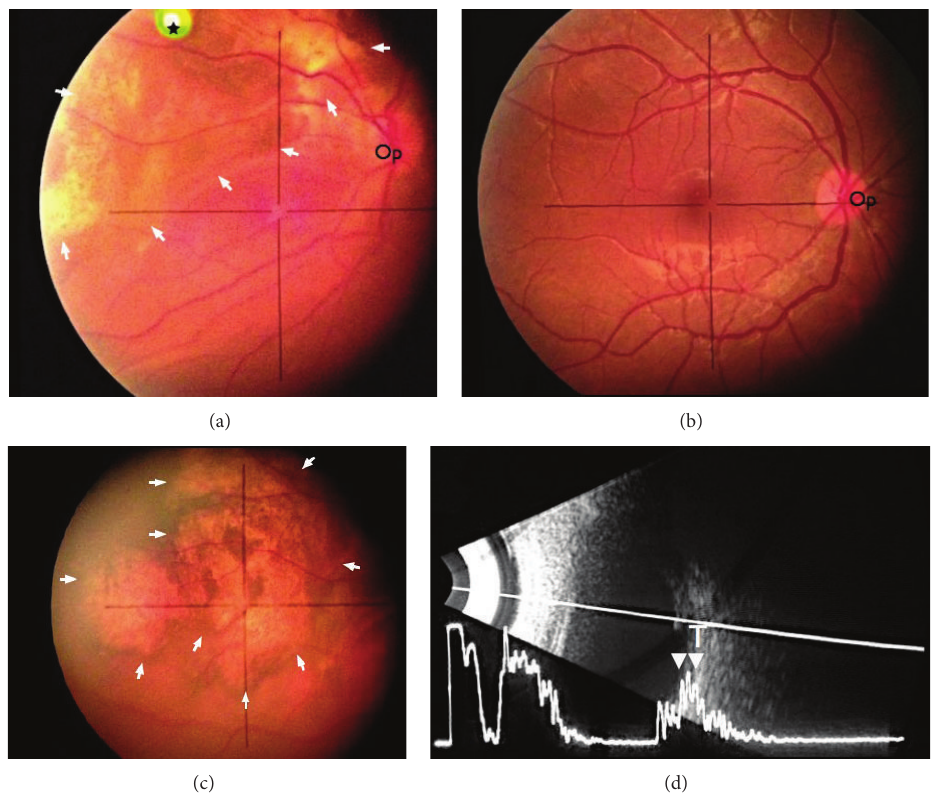
Figure 2: Selected fundoscopy images of the retina (a) at the level of the left optic nerve (Op) and (b) at the level of the right optic nerve (Op); (c) left nasal equatorial retina; (d) ultrasound B-scan with vector A scan. Images (a) and (c) show multiple ill-defined tumors with irregular surface (marked with white arrows in images (a) and (c)). Image (b) shows the comparative normal appearances of the right side. Image (d) shows the retinal lesion (T) with high intralesional reflectivity (white arrowheads). 󳀅 is